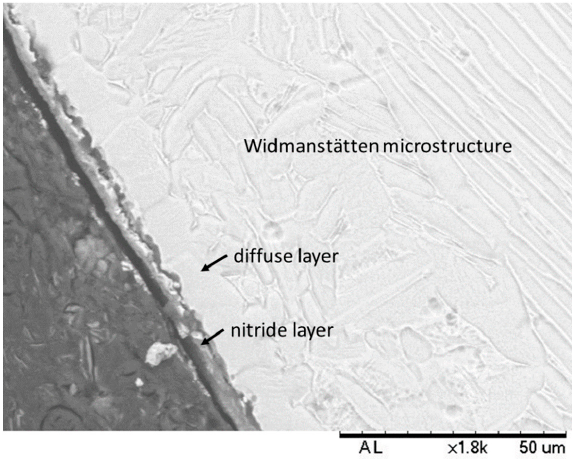
Figure 2. Scanning electron micrograph of the Ti-6Al-4V alloy after plasma nitriding. The arrows indicate the titanium nitride layer and the nitrogen diffusion layer in the matrix.